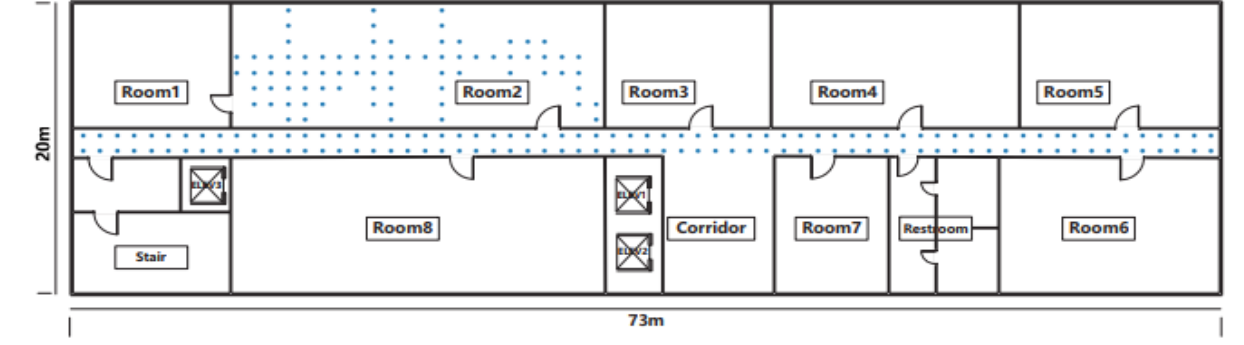
Figure 3. Experimental environments for dataset A showing the RP locations in blue circles.